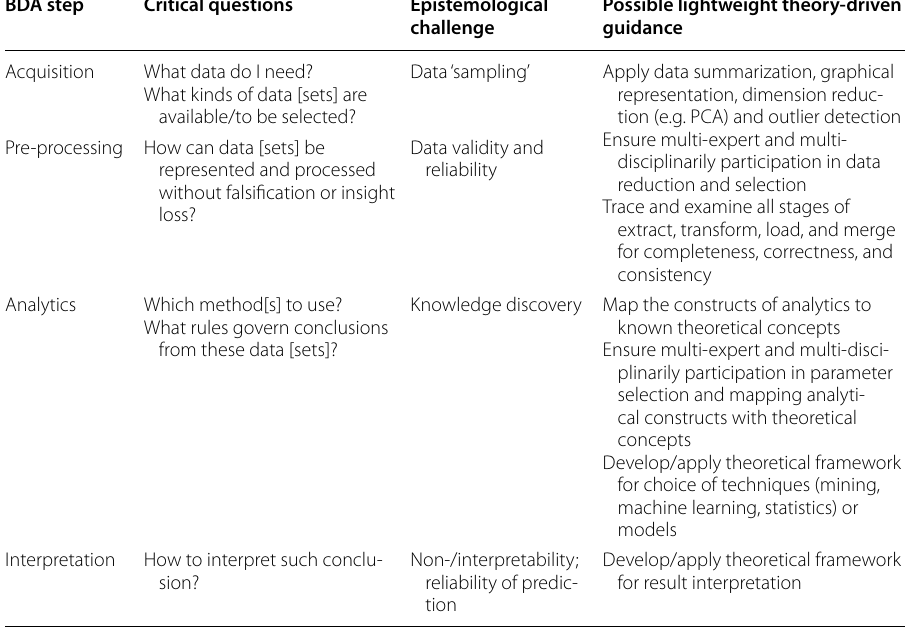
Table 1 Lightweight theory-driven guidance for the BDA